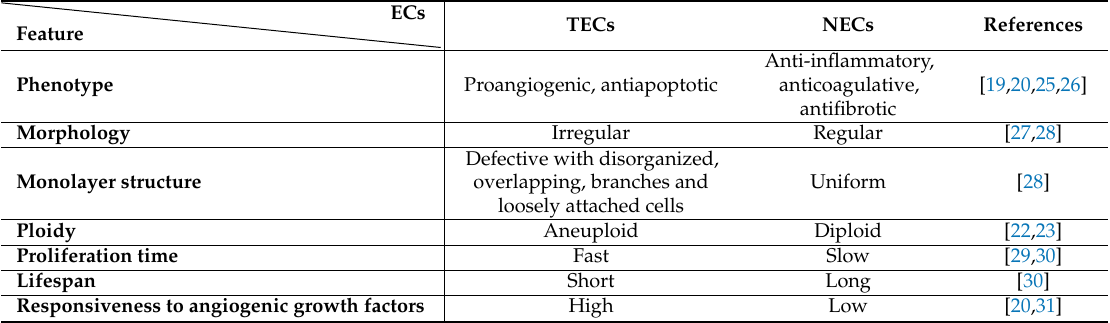
Table 1. Summary of the main di ff erences between tumor endothelial cells (TECs) and normal endothelial cells